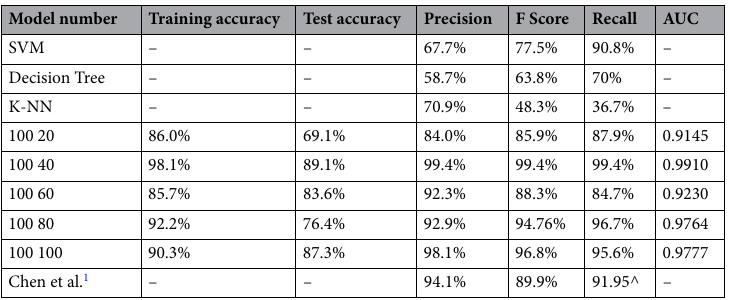
Table 1. Comparison and performance evaluation of the different proposed deep stacked sparse autoencoder neural